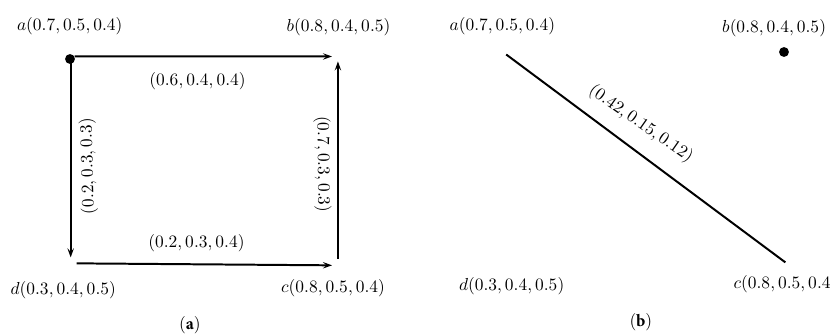
Figure 5. INC-graph. ( a ) IN-digraph; ( b ) corresponding